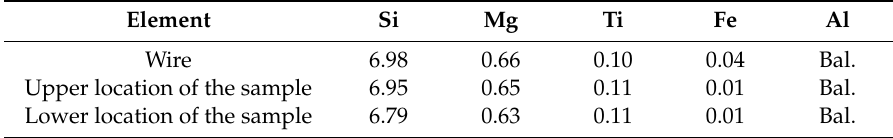
Table 1. The chemical composition of AlSi7Mg0.6 wire and samples (mass fraction, wt%). Element Si Mg Ti Fe Wire Upper location of the